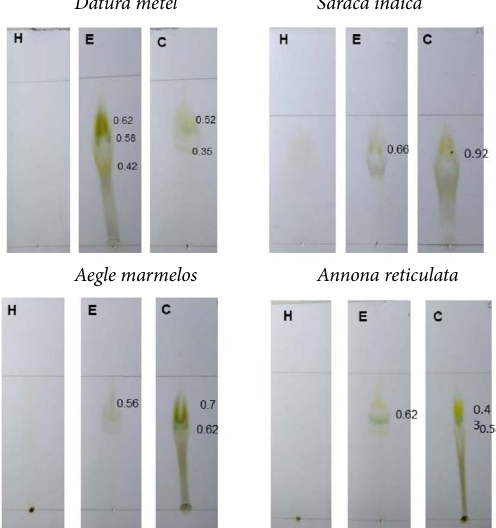
Fig. 4. TLC bioautography for Antibacterial activity of medicinal plants chosen for this